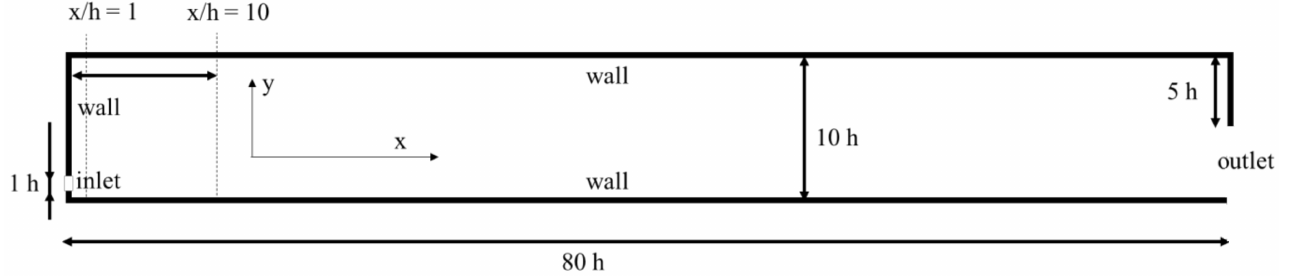
Figure 2. The flow-case investigated in this study, chosen to capture the main features of the confined turbulent wall-jet in which drop breakup takes place in high-pressure homogenizers and rotor-stator mixers. Dashed vertical lines show the location of x/h = 1 and x/h = 10.